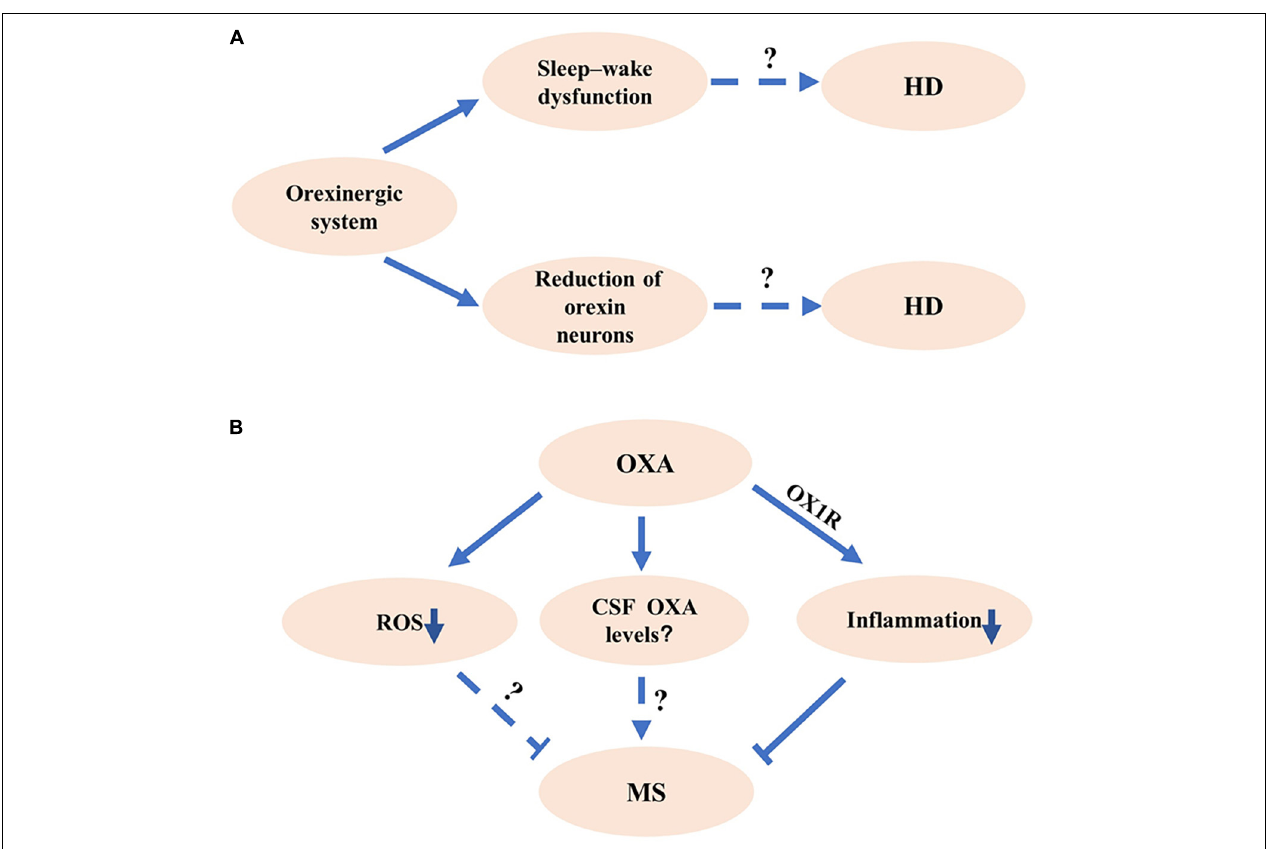
FIGURE 2 | The potential roles of orexinergic system in Huntington’s disease (HD) and multiple sclerosis (MS). (A) The potential roles of orexinergic system in HD. Studies show that the number of OX neurons decreased in HD. Abnormal sleep existed in HD. The details of orexinergic signaling in HD need to be further investigated. (B) The potential roles of orexinergic system in MS. The OXA/OX1R signaling significantly decreased the inflammation and pathological processes in EAE mice. Moreover, OXA could markedly reduce the reactive oxygen species (ROS) and microglial activation, indicating that the orexinergic system might involve